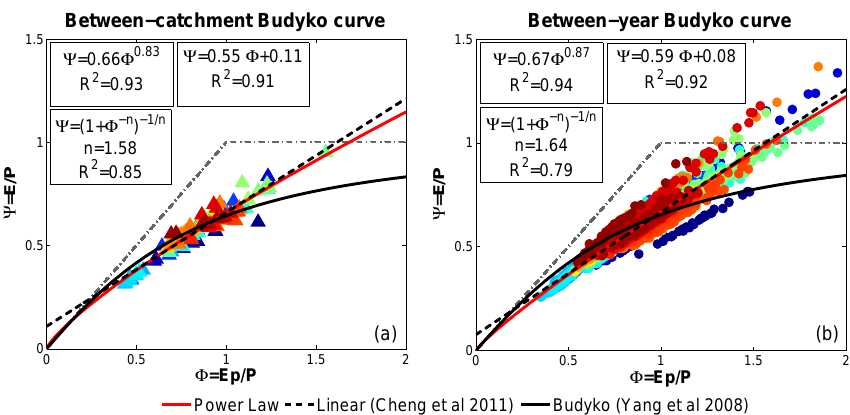
Figure 6. (a) Between-catchment variability of the long-term mean Budyko curve and (b) between-year variability of the Budyko curve. Colors denote different sub-catchments within Amazonia. The insets show the results of fitting Eqs. (6) and (9) and the linear relationship, with their respective